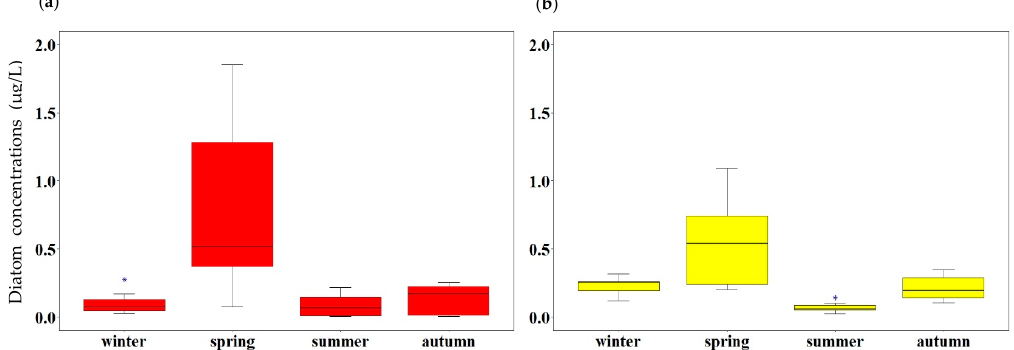
Figure 6. The concentrations of size-fractionated diatoms: ( a ) large-sized diatoms; and ( b ) small-sized diatoms. An asterisk (*) indicates an outlier.